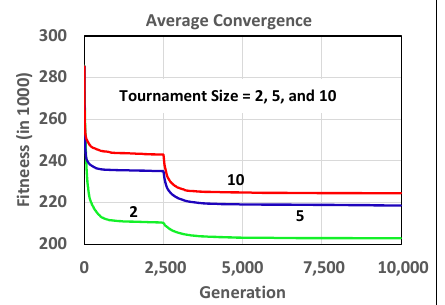
Figure 17. The average convergence from ten test runs of 2SGA using tournament selection under different tournament sizes while solving